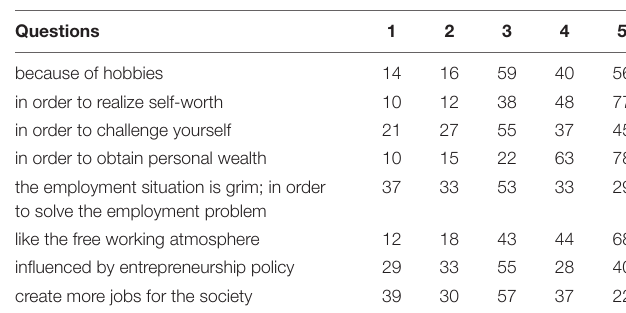
TABLE 3 | Entrepreneurial motivation of college students majoring in product design.